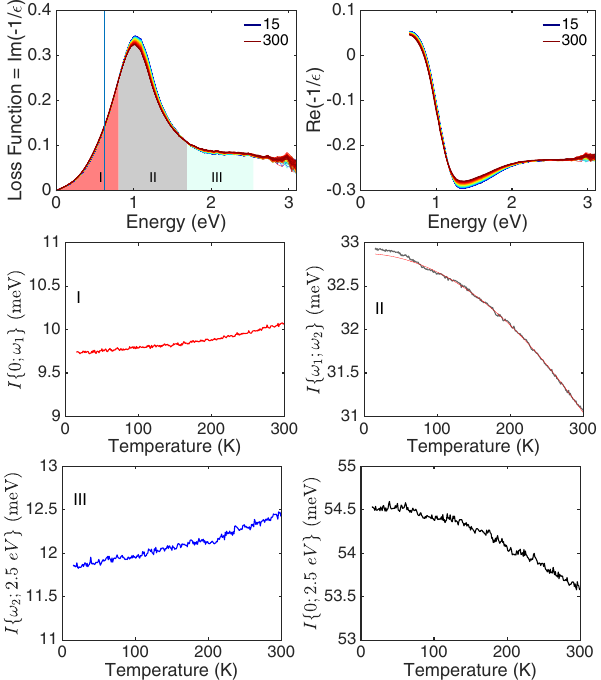
FIG. 10. Sample Bi2212-83-UD. Caption details as in Fig. 8. The value of the fitted exponent α is